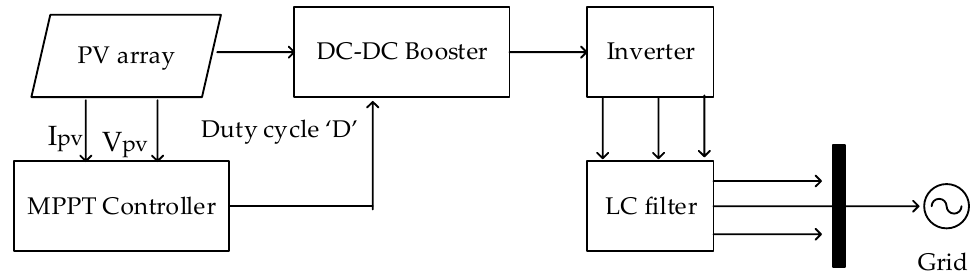
Figure 15. Block diagram of grid-connected PV system.